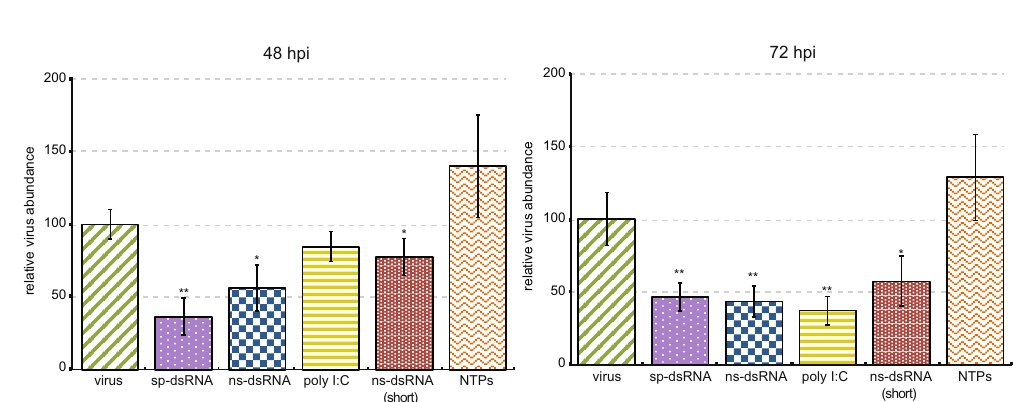
Figure 2. Relative virus RNA abundance was reduced in dsRNA-treated bees as compared to virus-infected bees. Relative abundance of SINV-GFP in individual bees (n = 10) was assessed by qPCR. ( A ) At 48 hours post-infection (hpi), bees treated with dsRNA (1 kb) had reduced relative virus RNA abundance (includes both virus genomes and transcripts) by 64% for sp-dsRNA-treated bees (dotted purple, ** p < 0.005) and 44% for ns- dsRNA-treated bees (checkered blue, * p < 0.05), as compared to bees infected with virus only (green stripes). Likewise, bees treated with short dsRNA (0.5 kb) had 24% less virus (dotted red, * p < 0.05) than virus-infected bees. ( B ) At 72 hpi bees treated with dsRNA had reduced relative virus abundance by 54% ( ** p < 0.005) and 56% ( ** p < 0.005) for sp-dsRNA and ns-dsRNA, respectively. Similarly, bees treated with poly(I:C) (yellow stripes), a structural analog of dsRNA, had 63% less virus than virus-infected bees ( ** p < 0.005). Bees treated with short dsRNA also had 43% less virus (dotted red, * p < 0.05) than bees infected with virus alone. The virus abundance in bees treated with NTPs (orange wavy lines) was not significantly different from virus- infected bees at either 48 hpi (A) or 72 hpi ( B ). Percent relative virus abundance for each sample was determined via ΔΔ CT analysis (using Am rpl8 as the house keeping gene); statistical differences between treatment and virus-infected bees were performed using one-sided Student’s t-tests, * p ≤ 0.05, ** p ≤ 0.005. The bars represent the standard error of the